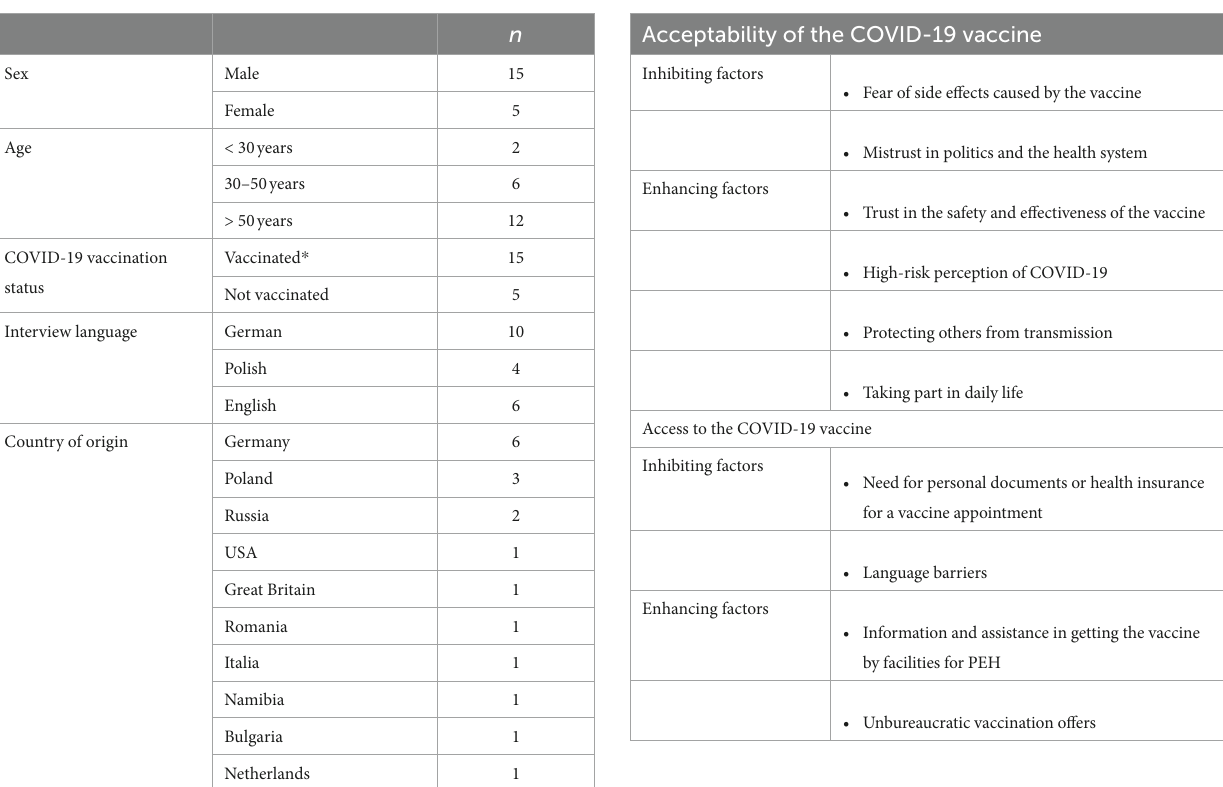
TABLE 3 Summary of categories. TABLE 2 Sociodemographic data of interviewees ( N =